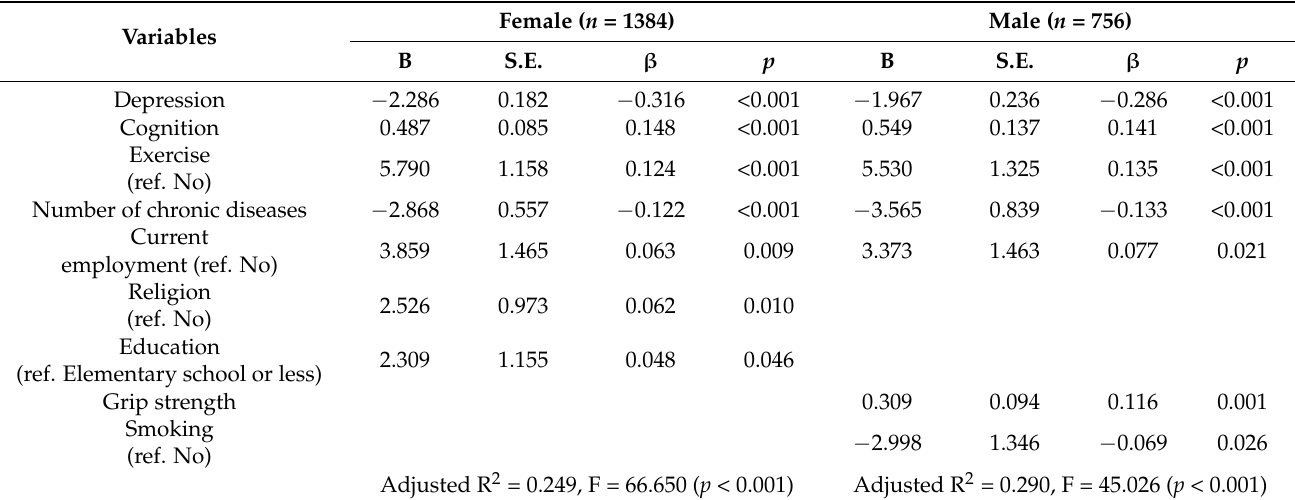
Table 3. Factors affecting life satisfaction with health by gender ( n = 2140).